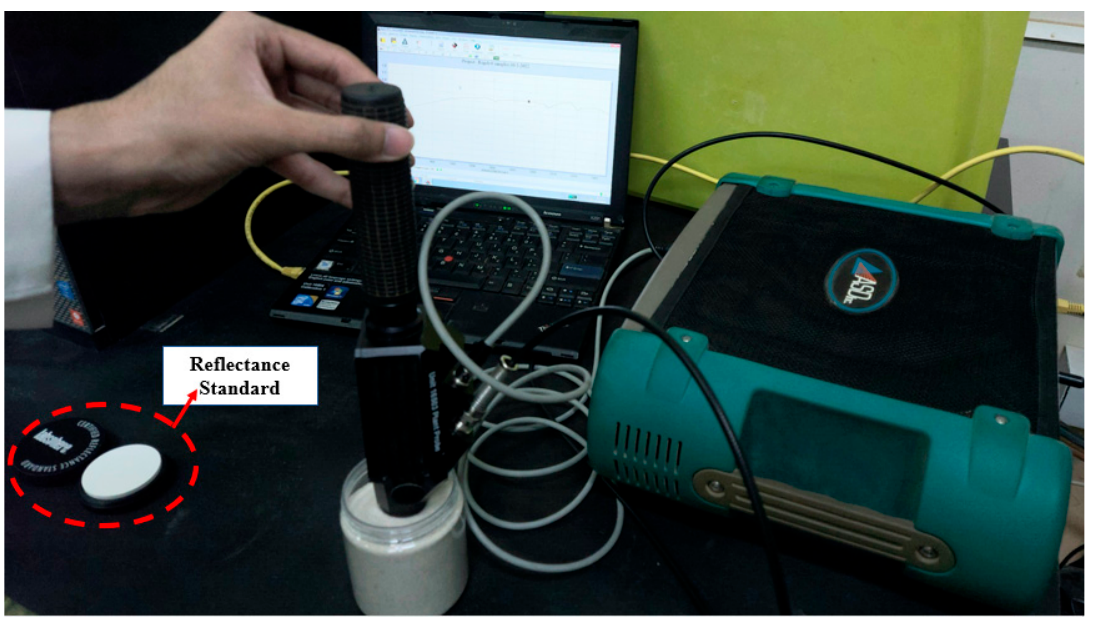
Figure 2. Reflectivity measurement of particulate materials using ASD FieldSpe3 Portable Spectroradiometer device.